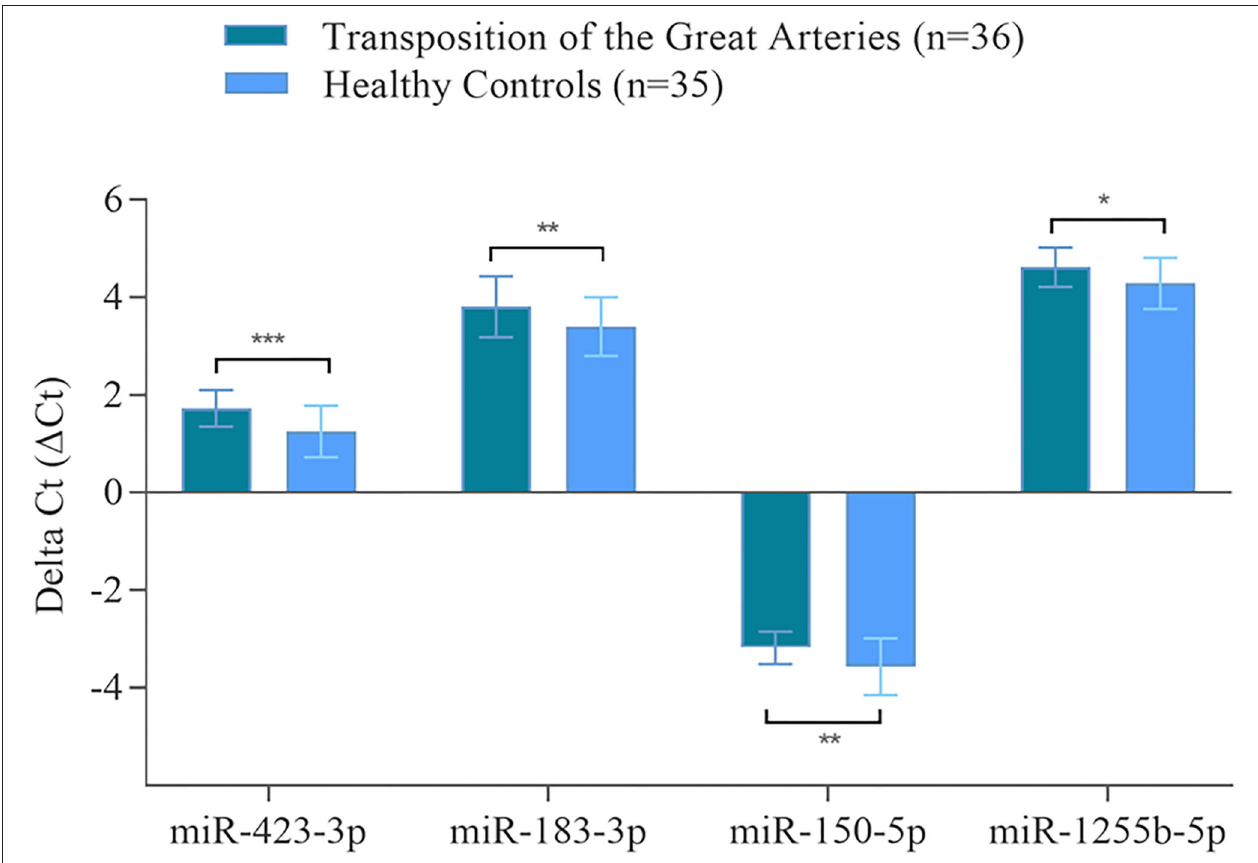
FIGURE 2 | Validated miRNAs in the blood of TGA-RV patients compared to healthy controls as determined by RT-qPCR. Mean 1 Ct of all TGA-RV patients and 1 Ct of all healthy controls (lower 1 Ct, higher abundance level). RNAU6B was used as endogenous control for normalization of miRNA. Unpaired Student’s t -test and mean ± standard deviation were used to evaluate differences in abundance levels. * p ≤ 0.05; ** p ≤ 0.01; *** p ≤ 0.001.